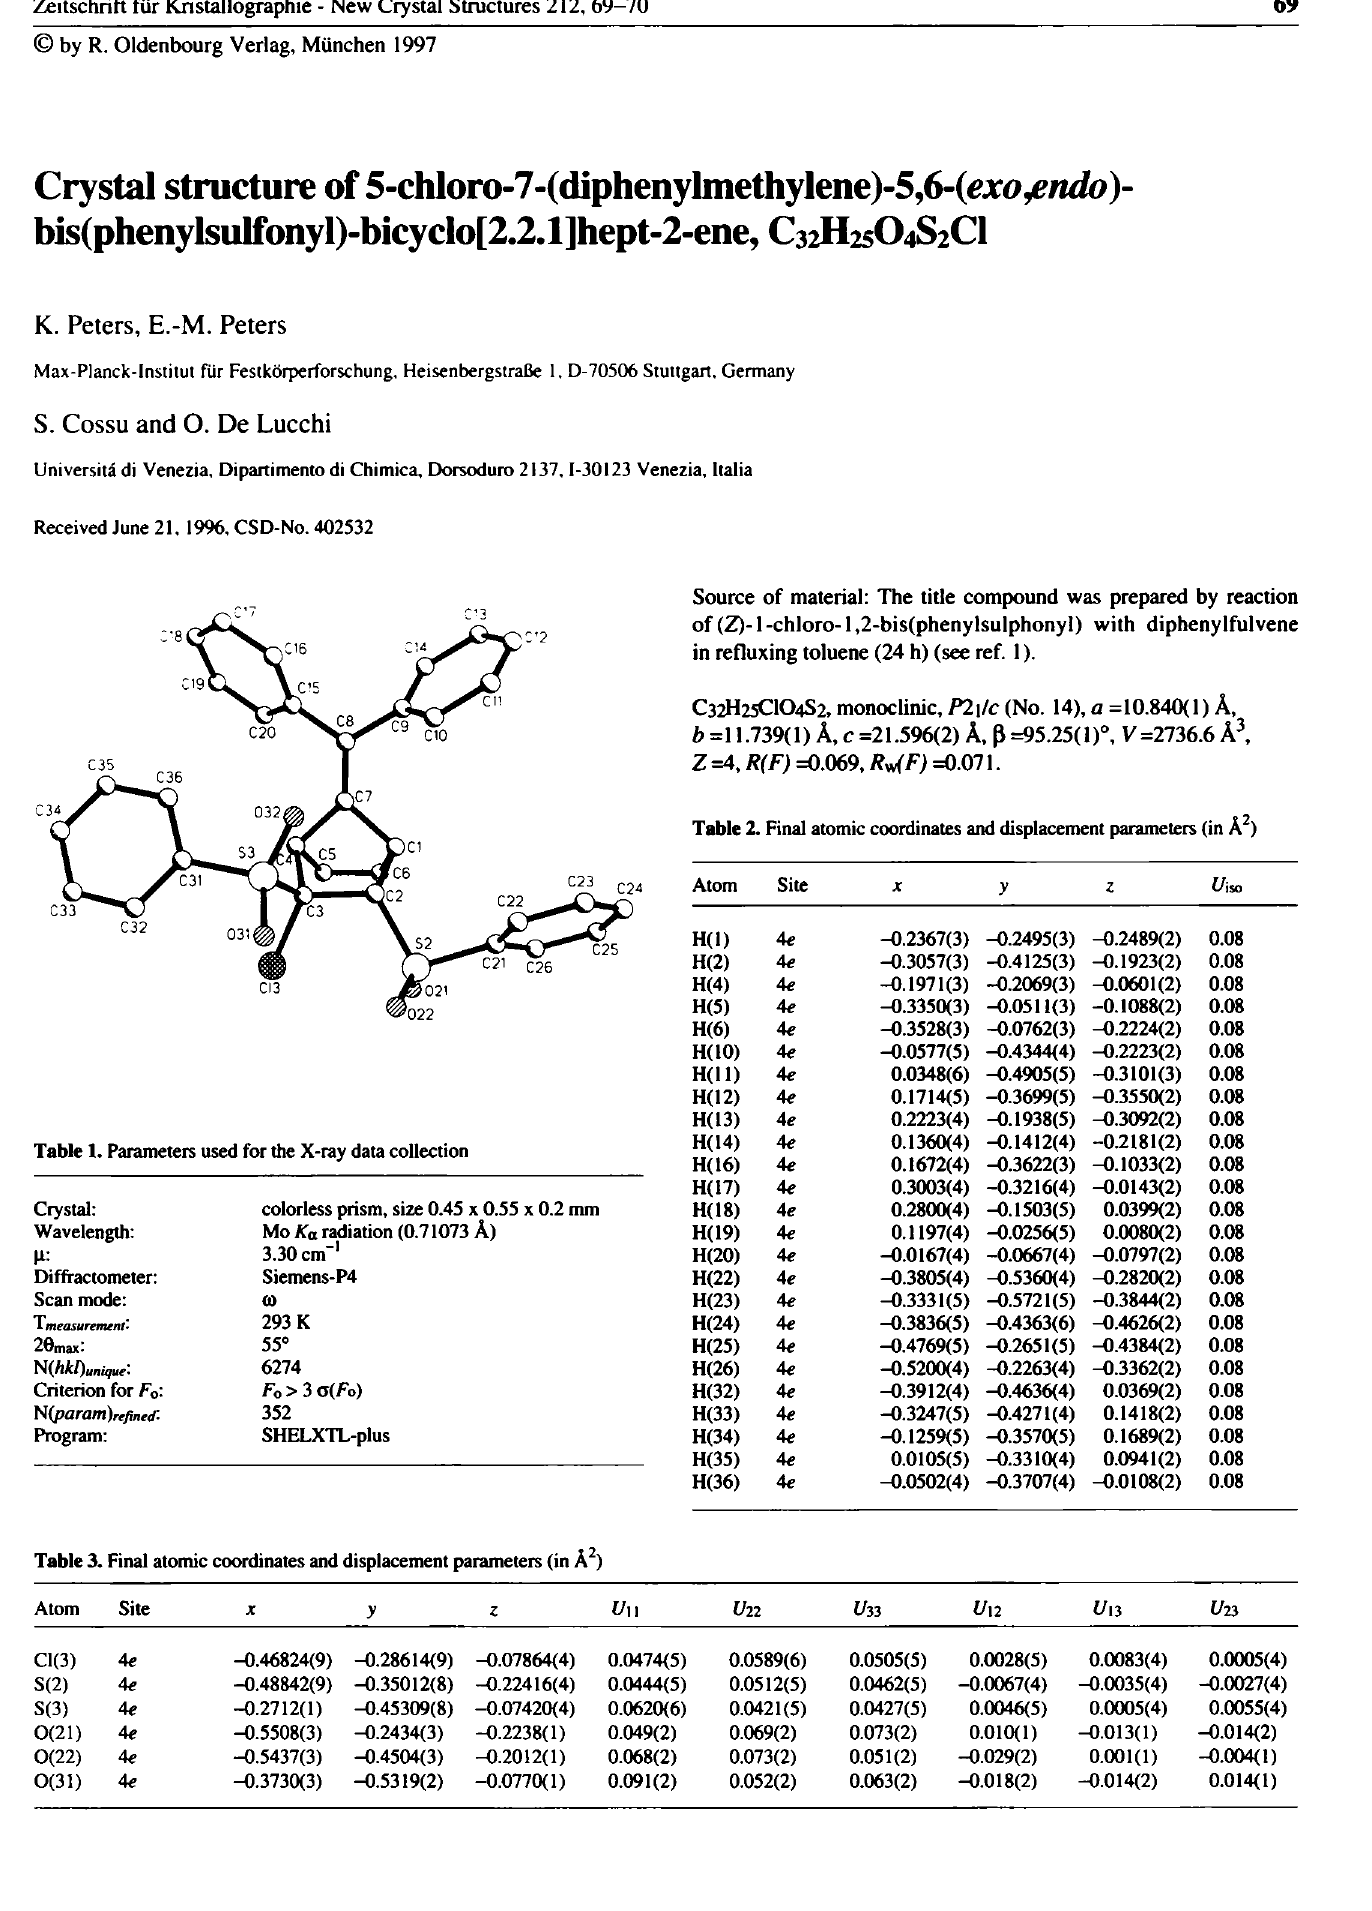
Source of material: The title compound was prepared by reaction